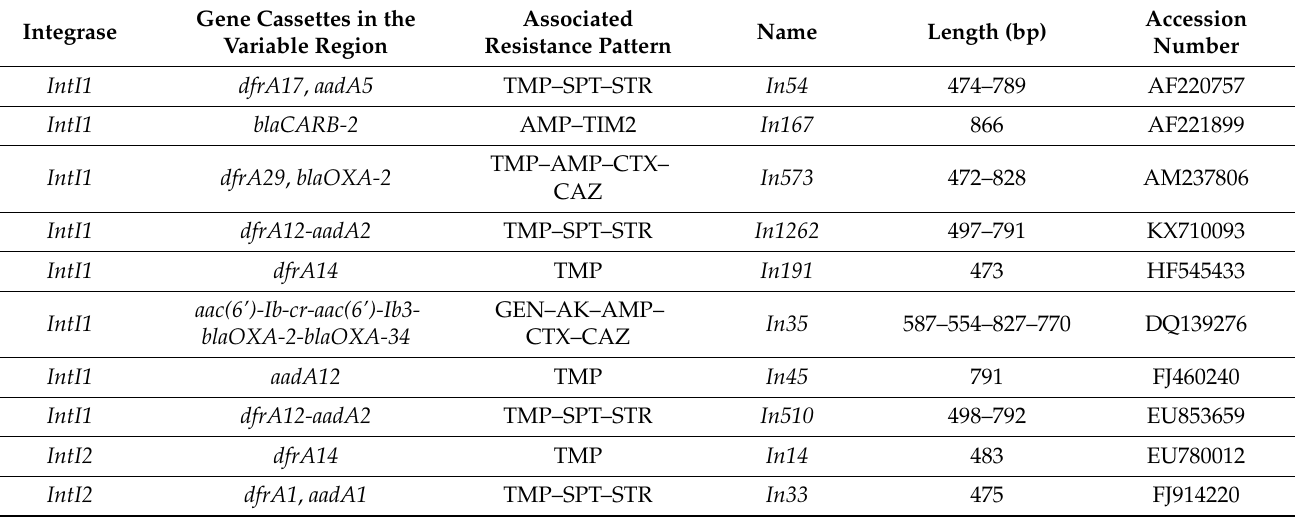
Figure 6. Number of integrons associated with antimicrobial resistance genes, organized by ( A ) source and ( B ) country. SPT, spectinomycin; STR, streptomycin; TMP, trimethoprim; AMP, ampicillin; CTX, cefotaxime; CAZ, ceftazidime; TIM2, ticarcillin/clavulanic acid; GEN, gentamicin; AK; akamicin; KAN; kanamycin. Table 1. Antimicrobial resistance genes detected among integrons identified in whole-genome sequenced isolates of Salmonella enterica from countries of the Andean Community according to IntFinder 1.0.